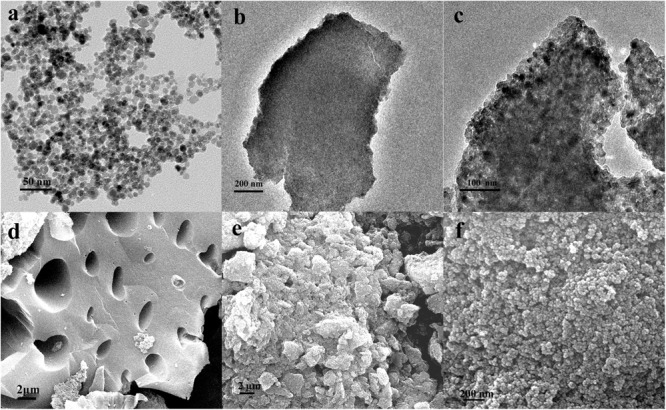
TEM micrographs of (a) Fe3O4 nanoparticles (NPs), (b) biochar, and (c) Fe3O4/biochar, SEM images of (d) biochar, (e) Fe3O4/biochar, and (f) magnified SEM image of Fe3O4/biochar.